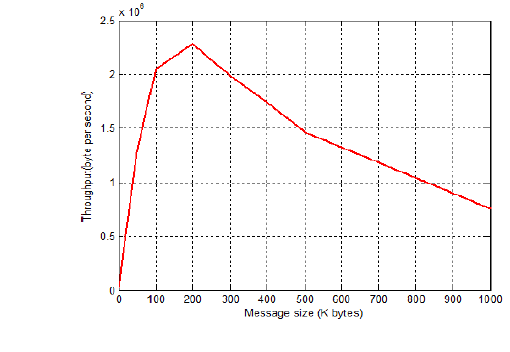
Fig. 14. Throughput drops when increasing message size Fig. 15. Throughput vs. block size